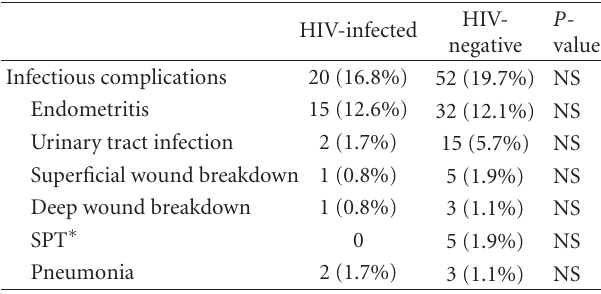
Table 4: Postoperative infectious complications among HIV- infected women and HIV-negative